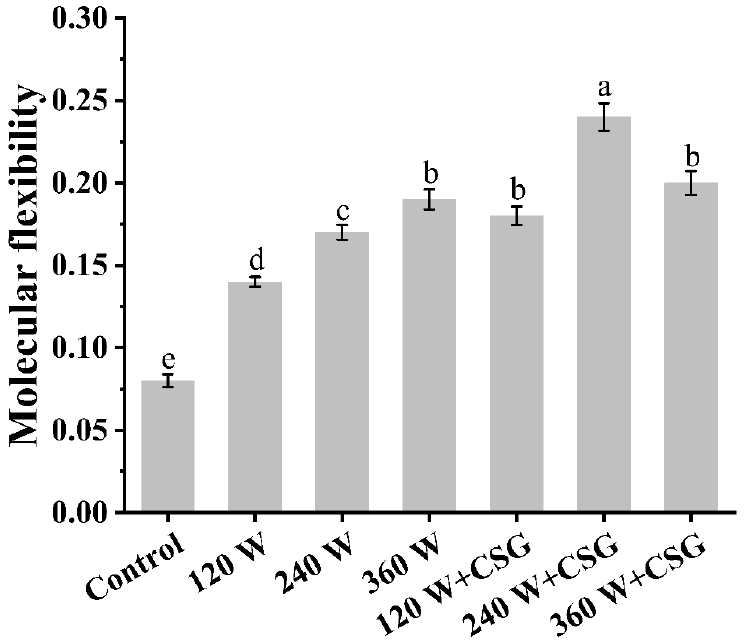
Figure 4. Protein molecular flexibility of WPI and WPI–CSG systems treated by different power ultrasound. Different lowercase letters represent significant differences ( p < 0.05) between data.